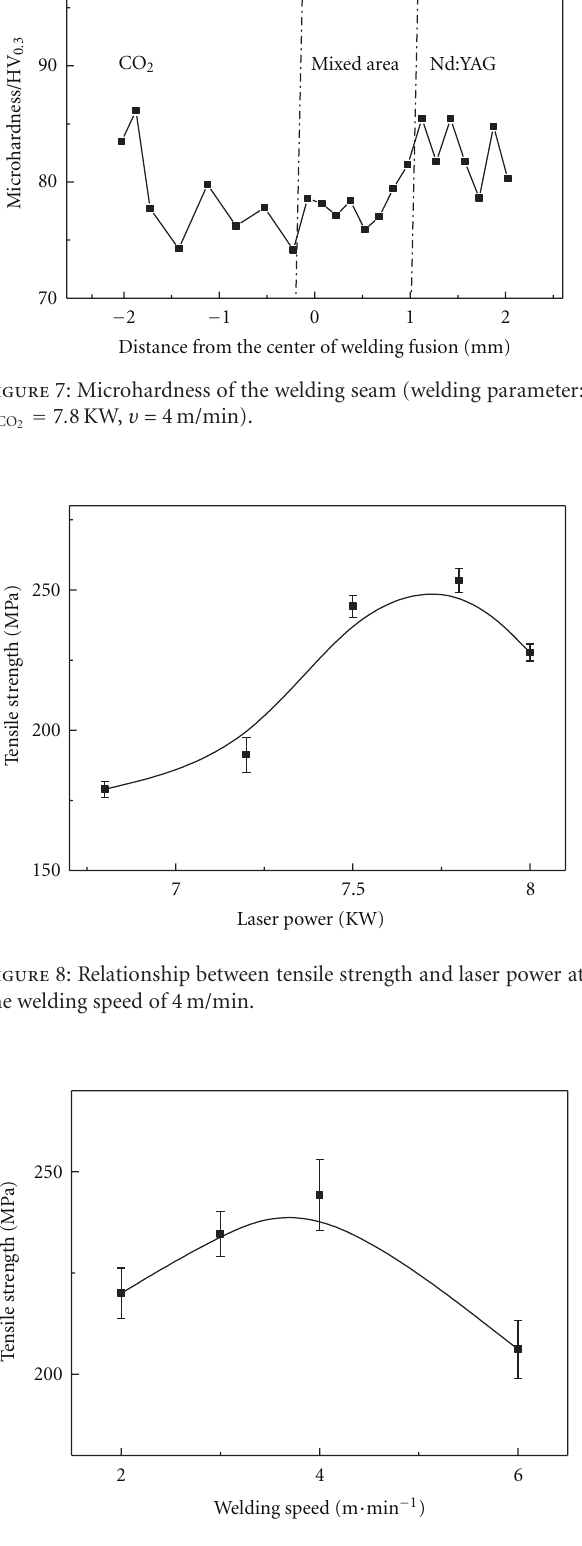
Figure 9: Relationship between tensile strength and welding speed at the laser power of